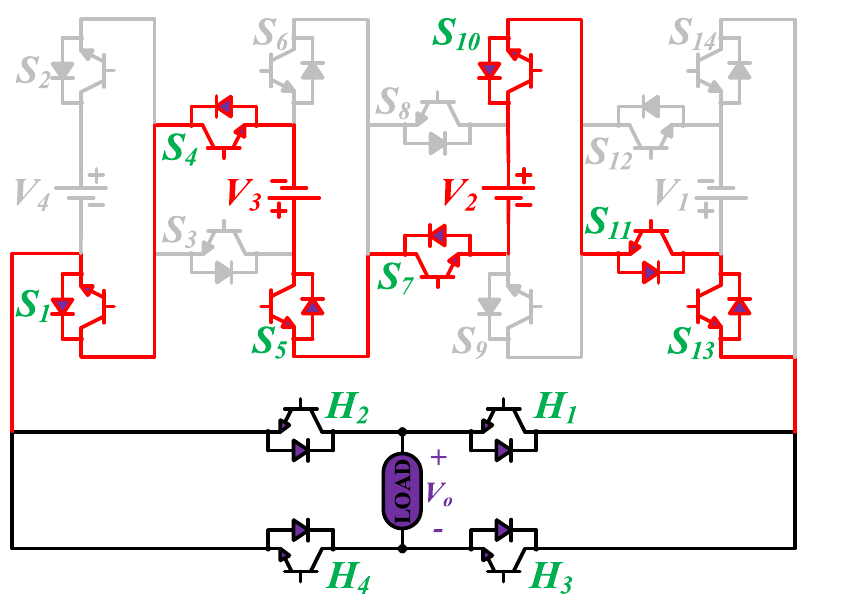
Fig 7. Switching states for voltage magnitude level